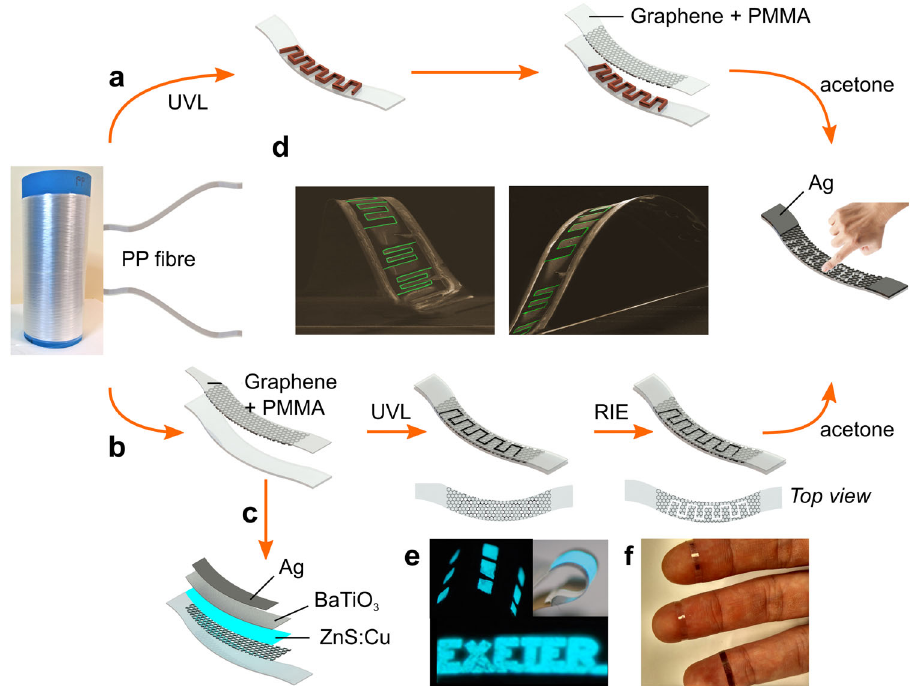
Fig. 1 Graphene-based devices on textile fi bres. Photos of the polypropylene textile fi bre; schematics of the step-by-step process to produce touch-sensing devices with a lithography process compatible with roll-to-roll manufacturing a and conventional lithography and etching process b . SEM pictures of the bent touch sensors are shown in d with the gap between graphene electrodes highlighted in green. Schematic and of photos of light emitting devices are shown in c and e . Photos of touch sensors are shown in